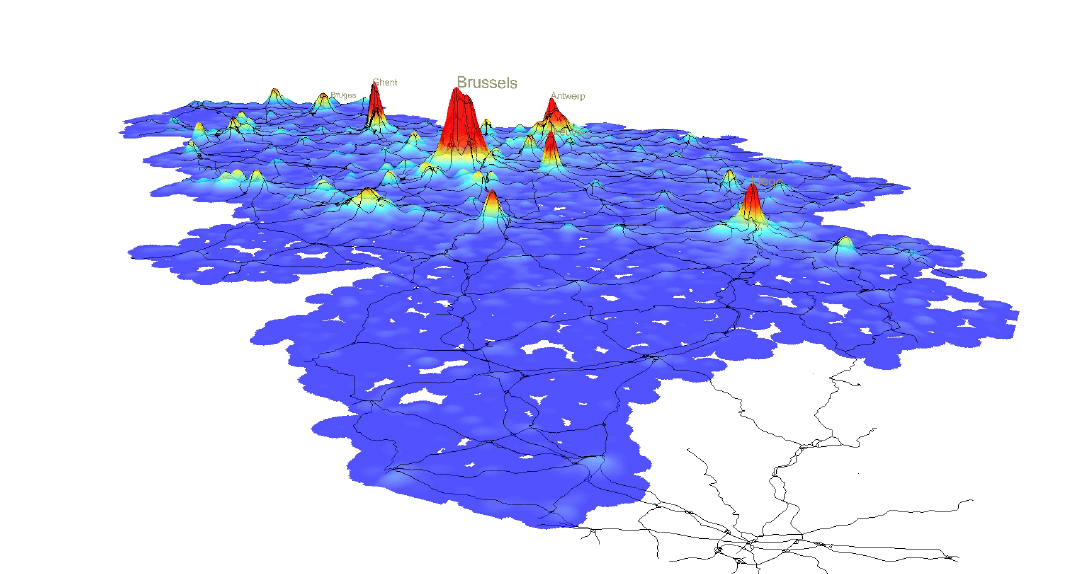
Figure 3. Density of smartphone subscribers in Belgium obtained through data from cellular network operators. Such data are characterised by a very high temporal resolution and can be used as a proxy to population